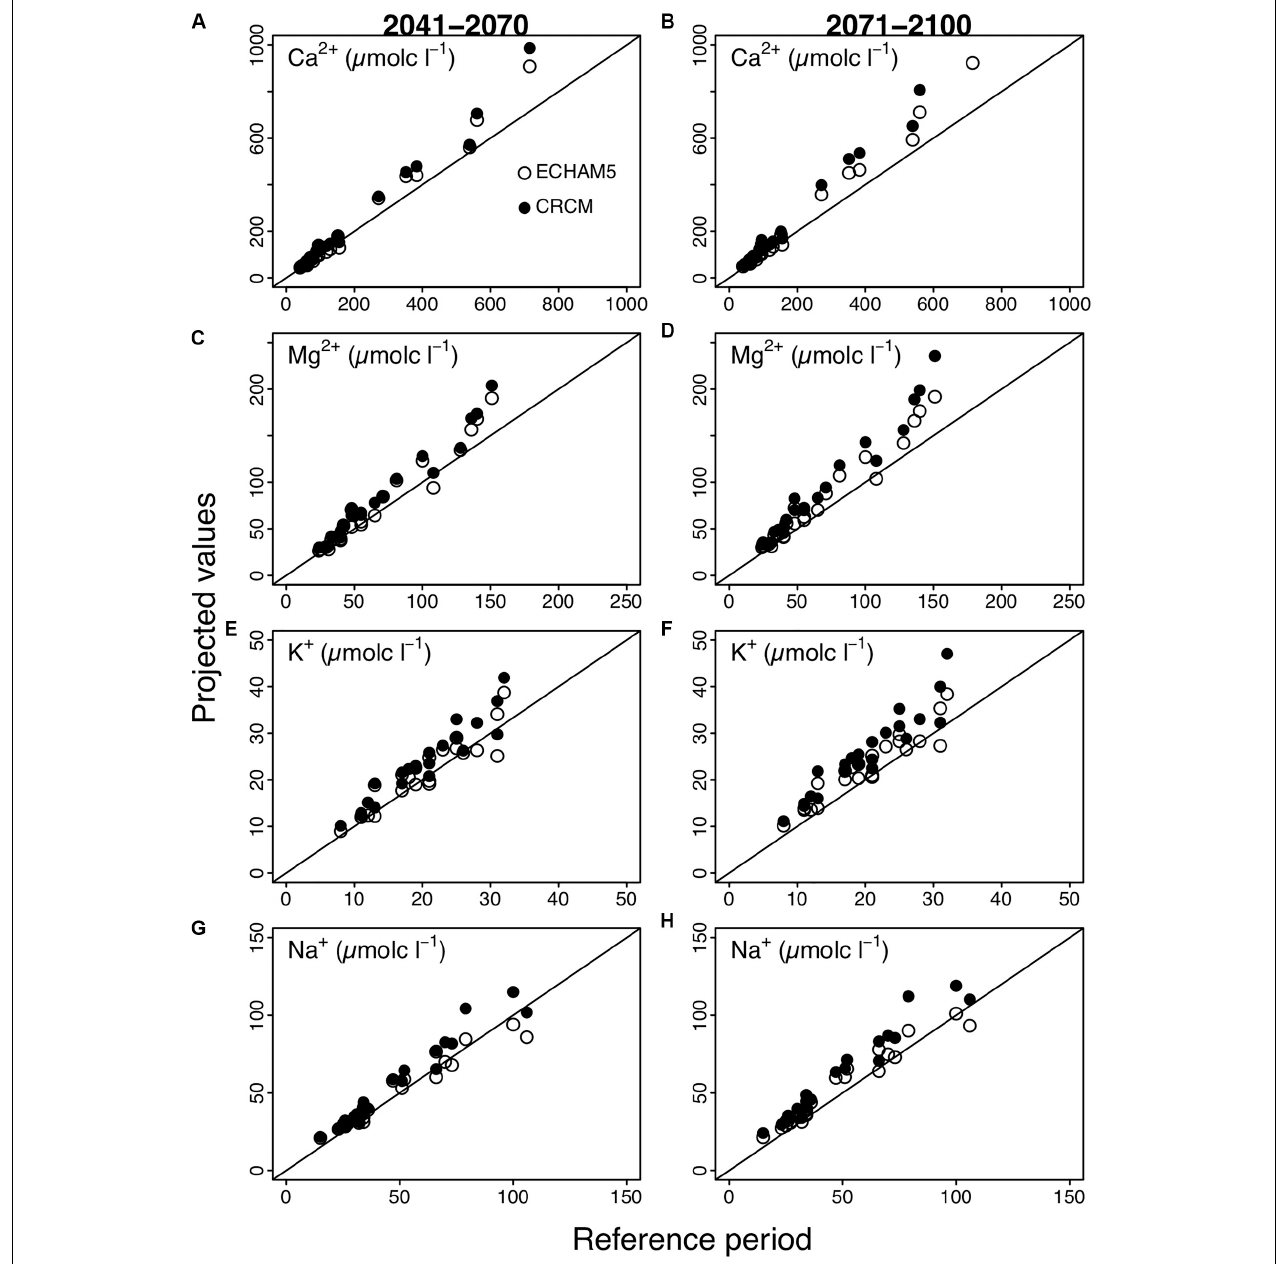
FIGURE 6 | Soil base cation concentrations ( µ mol c l − 1 ) for the reference period ( x -axis, 1971–2000) vs. the 2041–2070 (A,C,E,G) and 2071–2100 (B,D,F,H) periods as projected by the ECHAM 5 (global) and CRCM (regional) climate models. The full line is the 1:1 line.